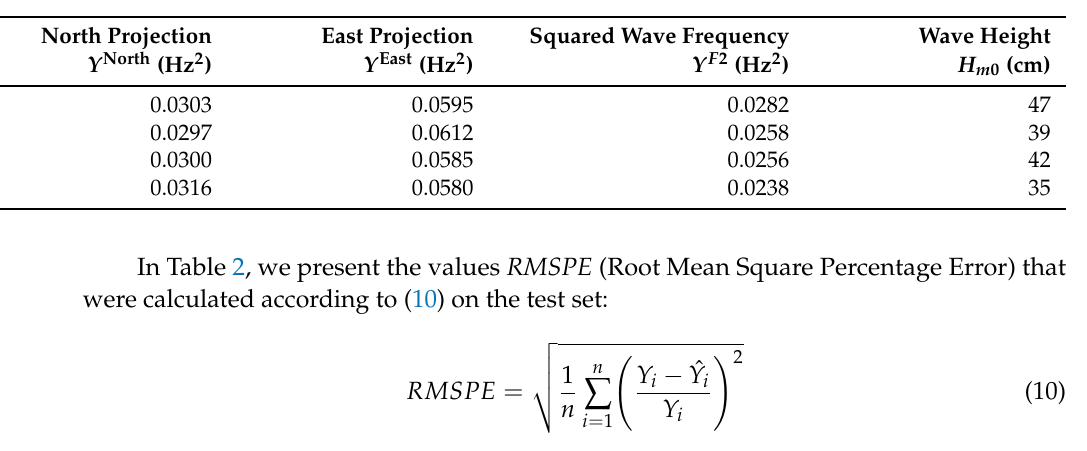
Table 1. RMSE values for XGBoost regression equipped with 30 trees with max depth of 3 on cross validation with 5